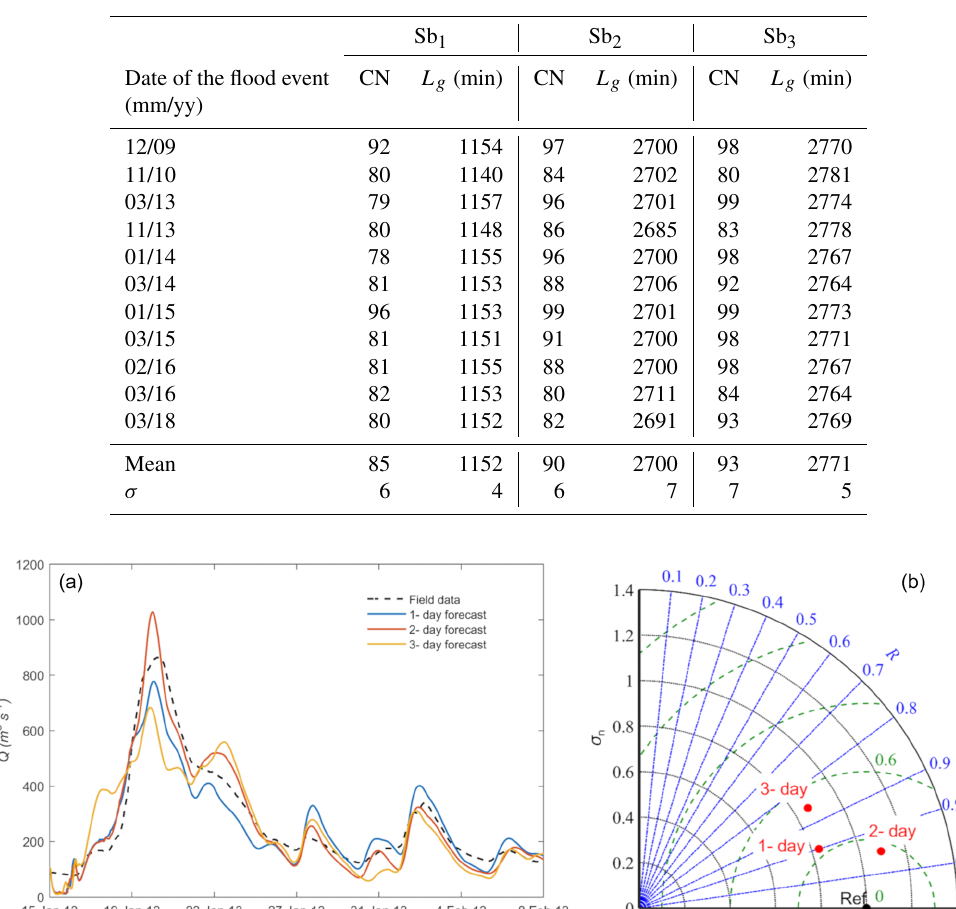
Table 5. Curve number (CN) and lag time ( L g ) values for each sub-basin for different flood events. The mean value and the standard deviation are provided in lower rows.